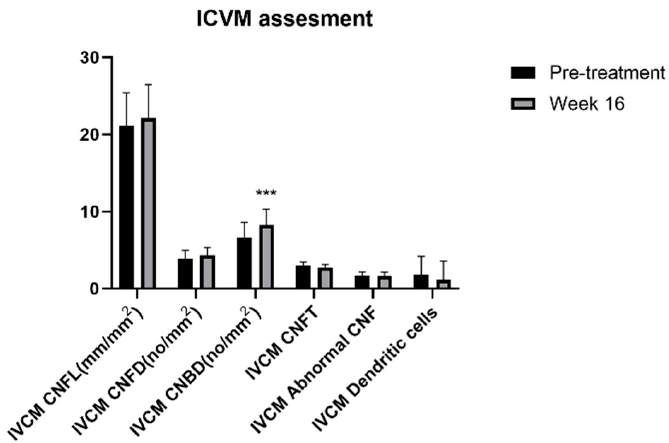
Figure 3. Changes of IVCM assessments before and after treatment of IPL combined with DCBE eye drops. *** p < 0.001. IVCM: In Vivo Confocal Microscopy, CNFL: Corneal Nerve Fiber Length, CNFL: Corneal Nerve Fiber Density, CNBD: Corneal Nerve Brand Density, CNFT: Corneal Nerve Fiber Tortuosity, CNF: Corneal Nerve Fiber.